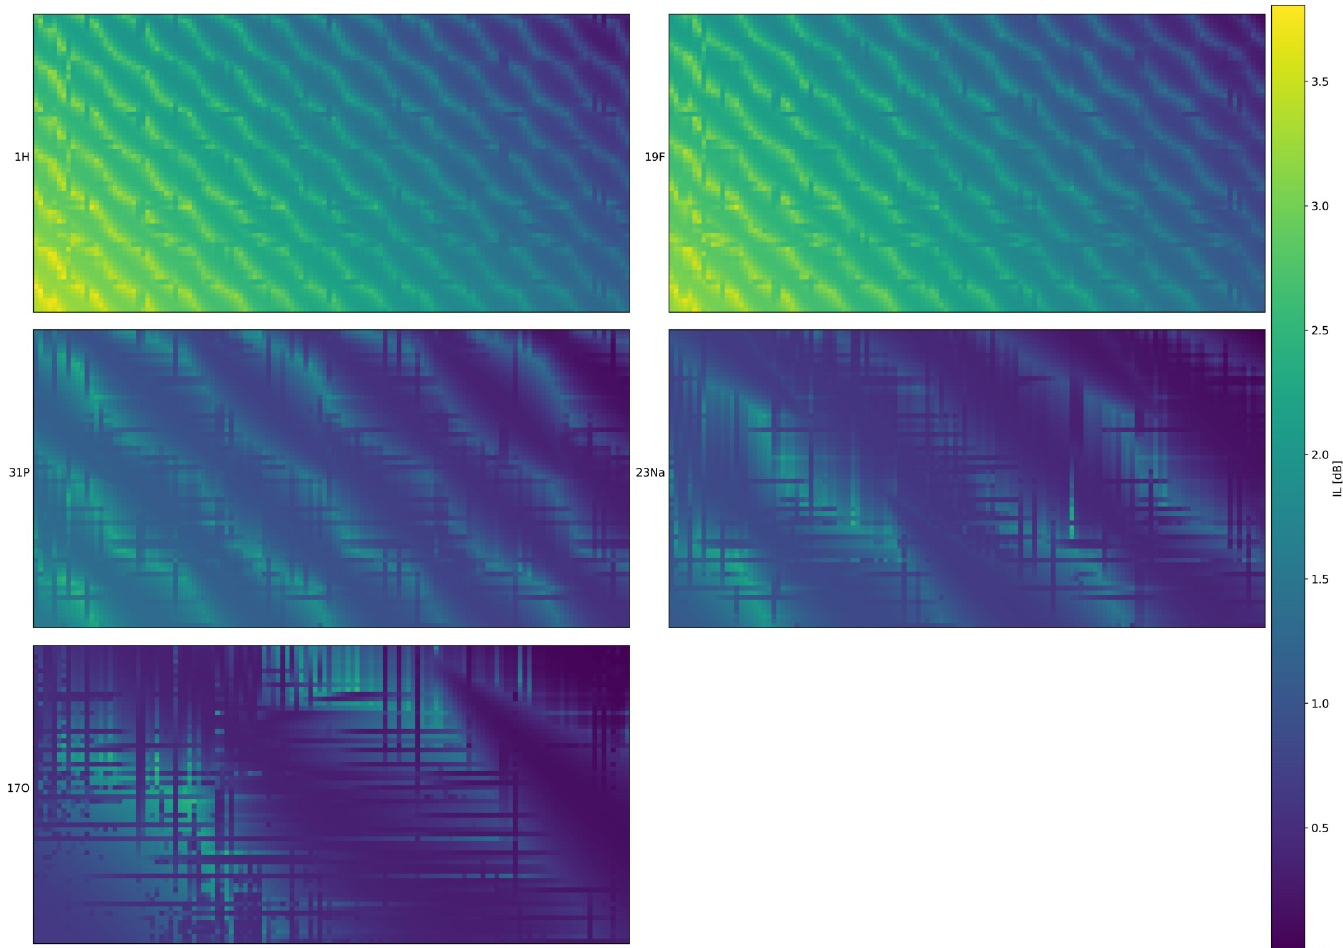
Fig 5. Maximum IL for the full switch matrix size for all nuclei investigated as obtained with the ε -MOEA algorithm. For better visibility, the switch matrix was rotated so that the output ports are shown on the left-hand side (abscissa) ranging from 1 (top) to 64 (bottom). The inputs are arranged along the ordinate and increase from right to left. Each color patch gives the maximum IL for the connection between the corresponding input and output port. All data are simulation results calculated using the transmission line formulas from Hammerstad et al. [53].